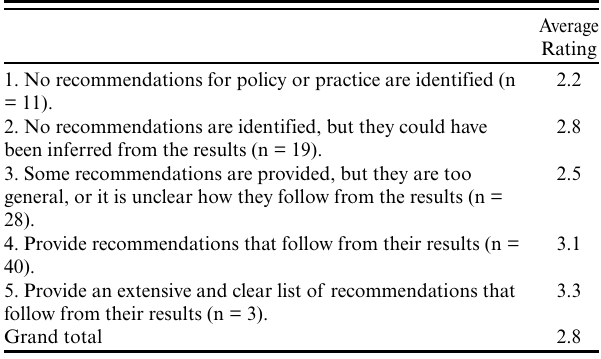
Table 5 . Comparison of integration ratings across studies providing different levels of